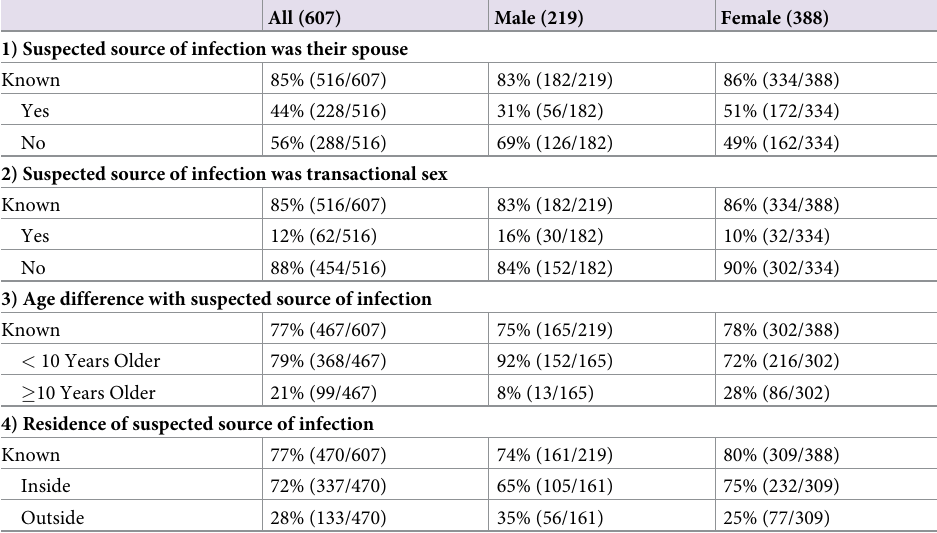
Table 3. Results in % (numerator/denominator) for the seroconverter survey for suspected sources and modes of HIV infection among the 607 participants, overall and by gender.